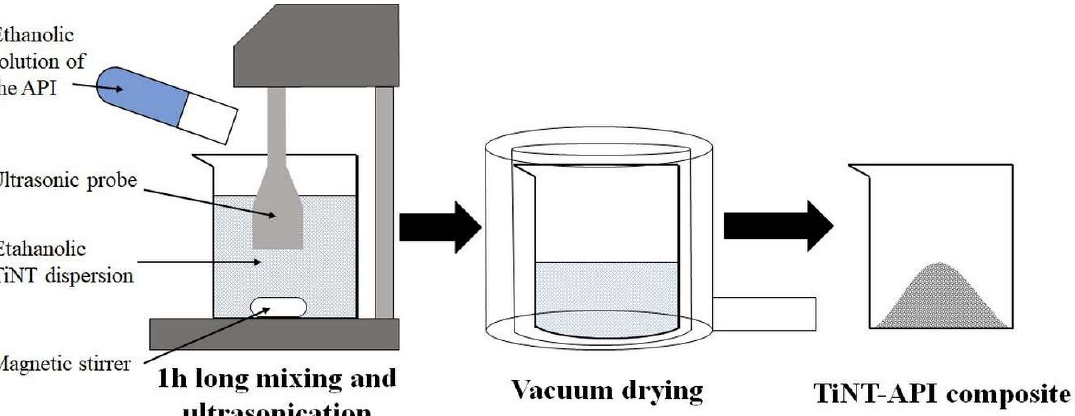
Figure 1. Schematic representation of the composite formation process.